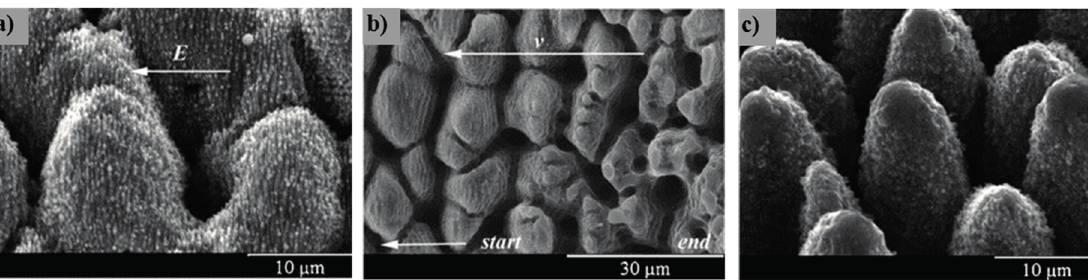
Figure 7. The effect of relative motion on LIPSS formation on Ti samples irradiated at 1 J/cm 2 fluence and with velocity of ( a ) and ( b ) 10 μ m/s, and ( c ) 50 μ m/s